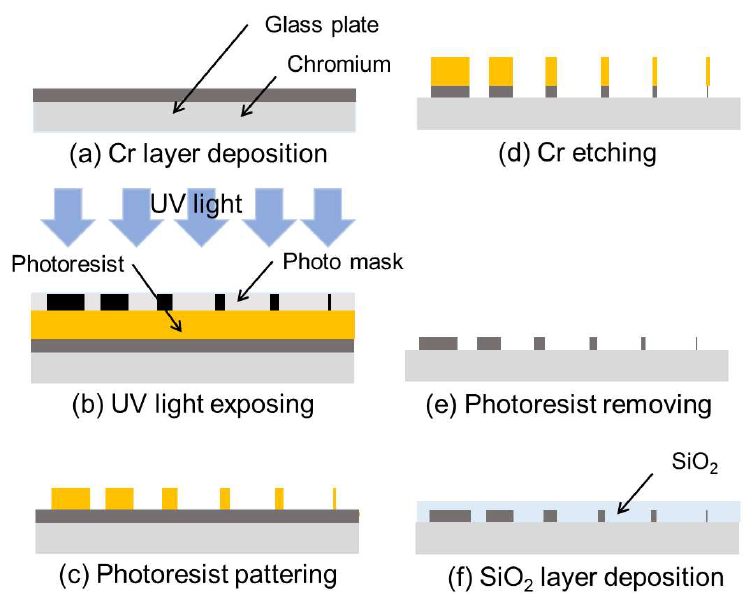
Figure 3. Fabrication process of the array of the electrodes. ( a ) Cr layer deposition. ( b ) UV light exposure. ( c ) Photoresist patterning. ( d ) Cr etching. ( e ) Photoresist removing. ( f ) SiO 2 layer deposition.